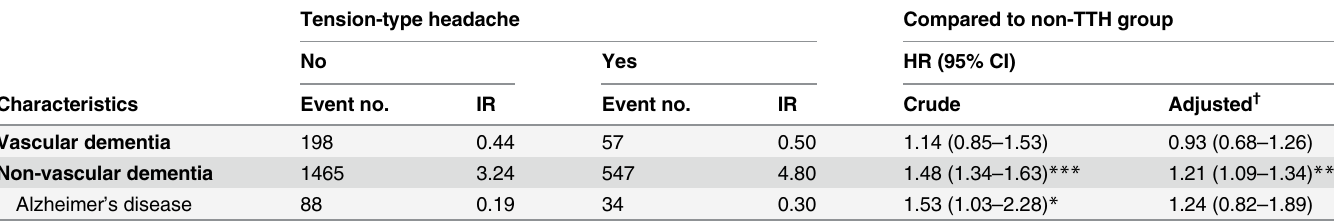
Table 4. Incidence density rates and hazard ratios of dementia according to tension-type headache